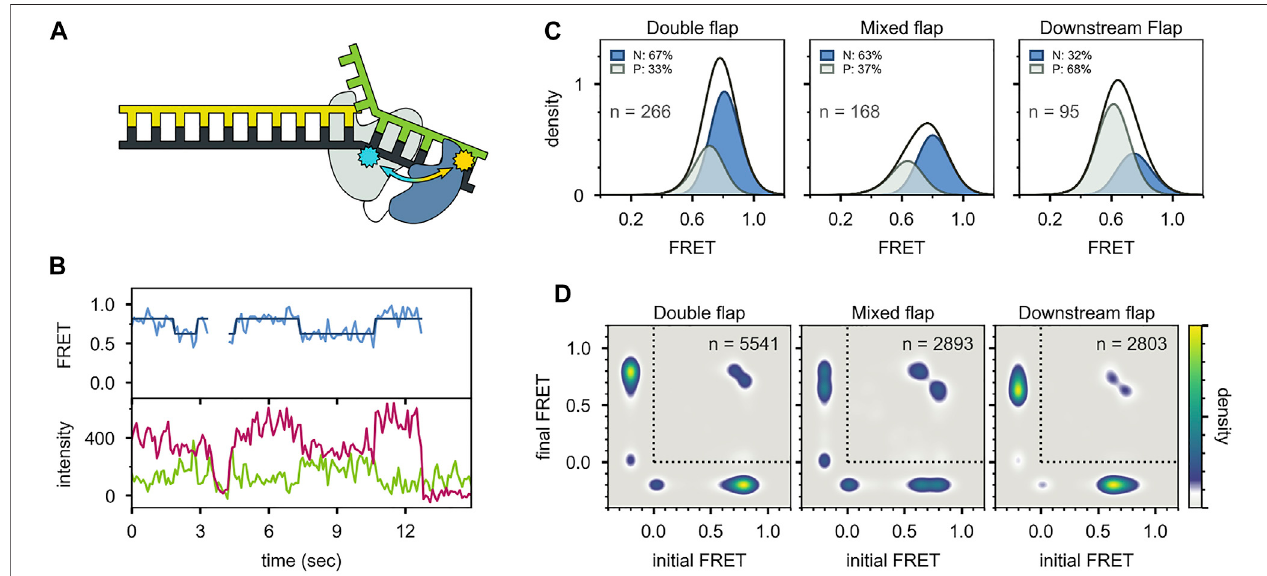
FIGURE 10 | smFRET data for Pol I — DNA complexes obtained using the second labeling scheme. (A) Locations of donor (yellow) and acceptor (blue). The polymerasecoreisgreyand 5 ′ nuc domainisblue. (B) Donorintensity(green),acceptorintensity(red)andFRETef fi ciency(blue)trajectoriesareshown.Theblacklineisa